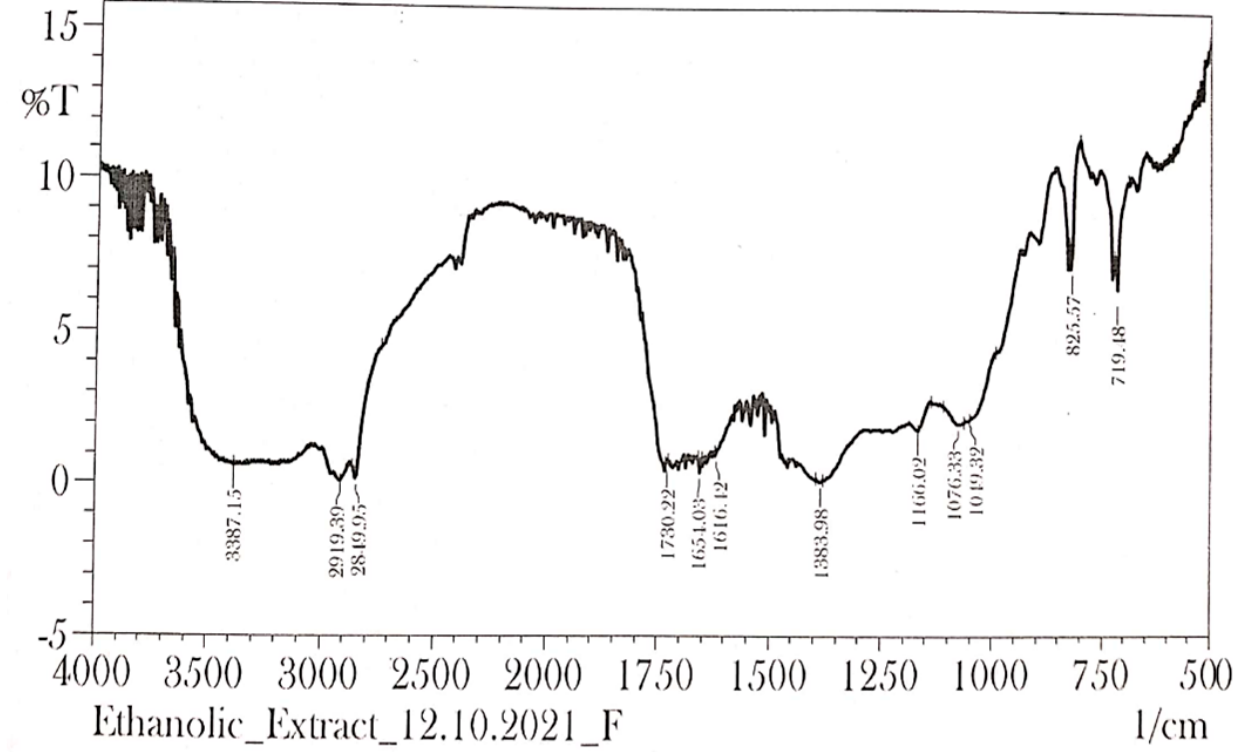
Figure 8. FTIR spectrum of ethanol extract of Carica papaya leaves.